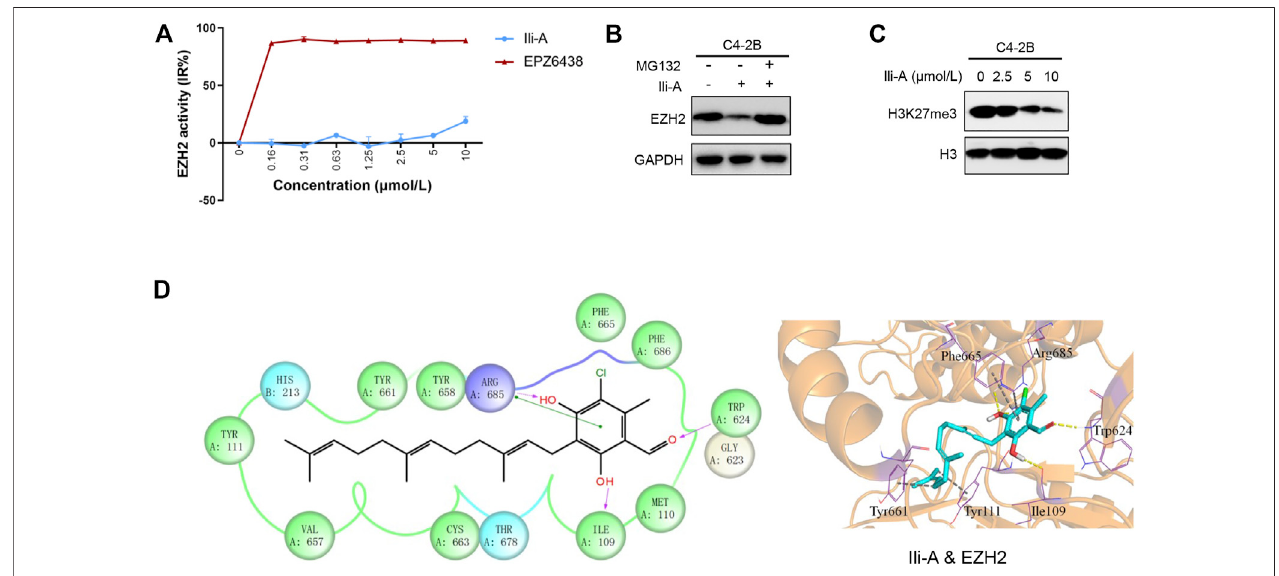
FIGURE 3 | Ili-A inhibits expression of EZH2-mediated signaling. (A) Biochemical inhibition of full-length human EZH2 by compound Ili-A and EPZ6438. (B) Immunoblotting showing an EZH2 protein-degraded pathway in C4-2B cells treated with vehicle or Ili-A for 18 h and MG132 for an additional 6 h. (C) Immunoblotting showing bulk histone methylation for H3K27me3 on acid-extracted histones in C4-2B cells treated with vehicle or Ili-A for 48 h. (D) Binding mode of Ili-A in the catalytic region of EZH2 by molecular docking. The hydrogen bonds are labeled by yellow dashed lines, and the hydrophobic interaction is shown as gray dashed